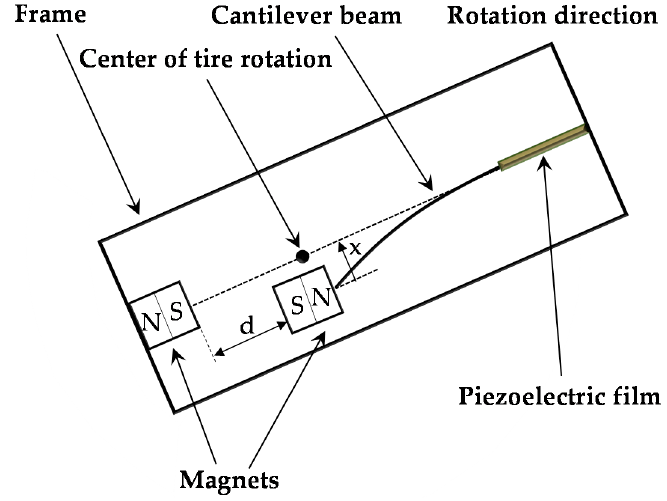
Figure 2. Diagram of the nonlinear bistable energy harvesting configuration.